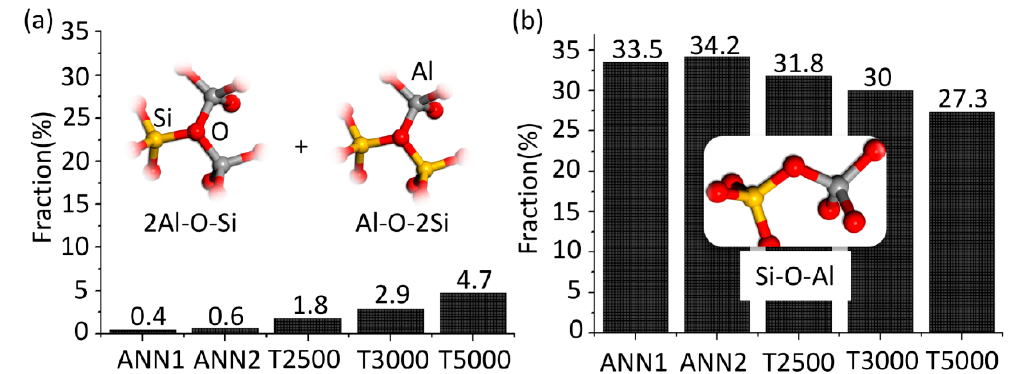
Figure 2. Fractions of triclusters of oxygen ions ( a ) and Al-O-Si bridging oxygen ions ( b ) for 30Ba obtained by simulated annealing (ANN1, ANN2) and inherent structure sampling for different temperatures (T2500, T3000, T5000).